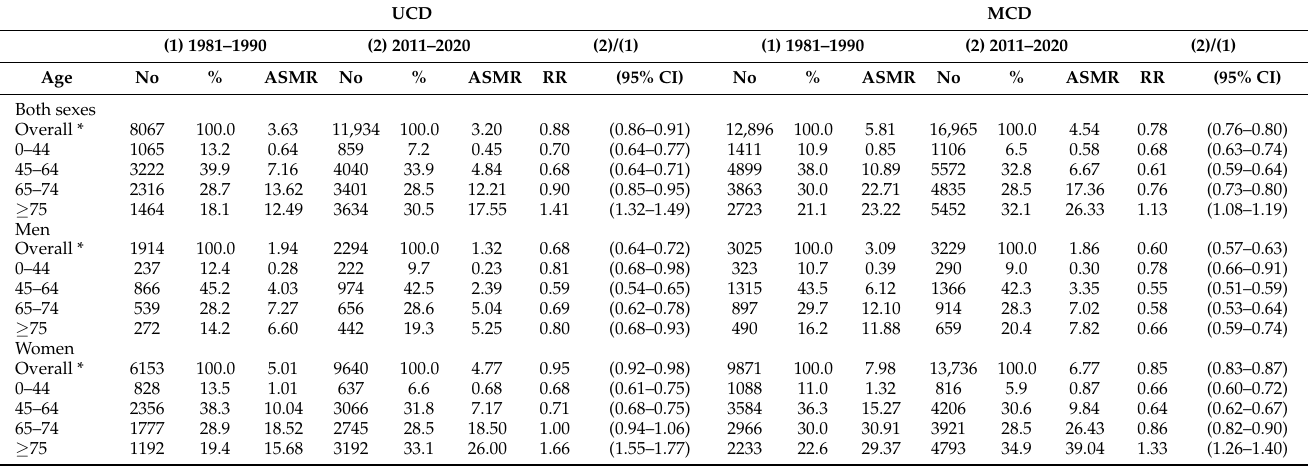
Table 1. Number of deaths (No), age-standardized mortality rate (ASMR), and mortality rate ratio (RR) of systemic sclerosis stratified by sex and age according to the underlying cause of death (UCD) and multiple causes of death (MCD), 1981–1990 versus